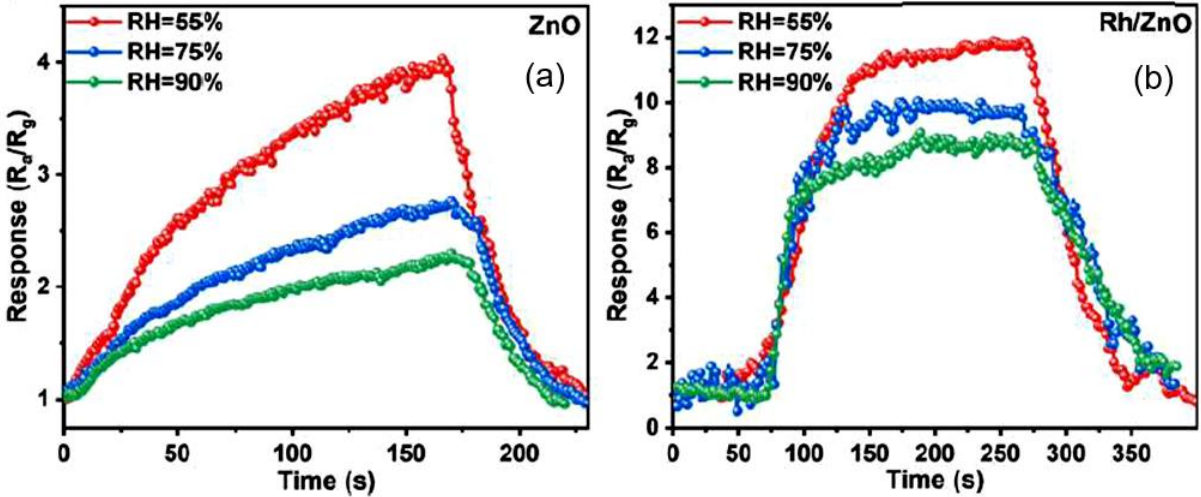
Figure 23. Response of ( a ) unmodified and ( b ) modified with Rh ZnO flower ‐ based sensor to 10 ppm TMA at 220 °C under different RH. Reprinted with permission from Li et al. [153]. Copyright 2022: Elsevier.